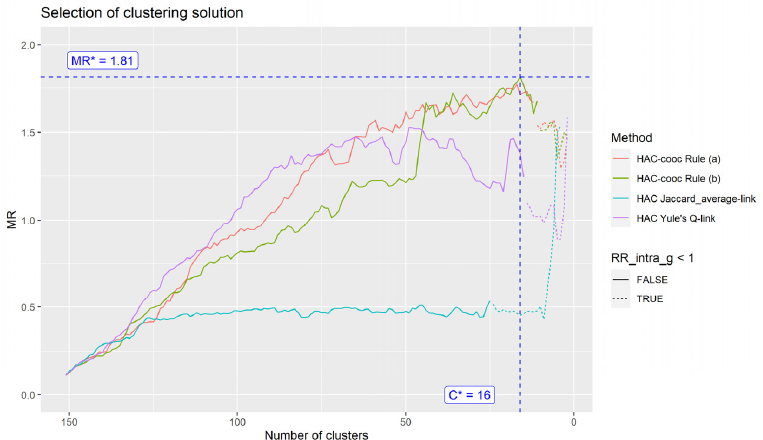
Figure 1. Graph of the evolution of the membership ratio (MR) criterion for each agglomeration